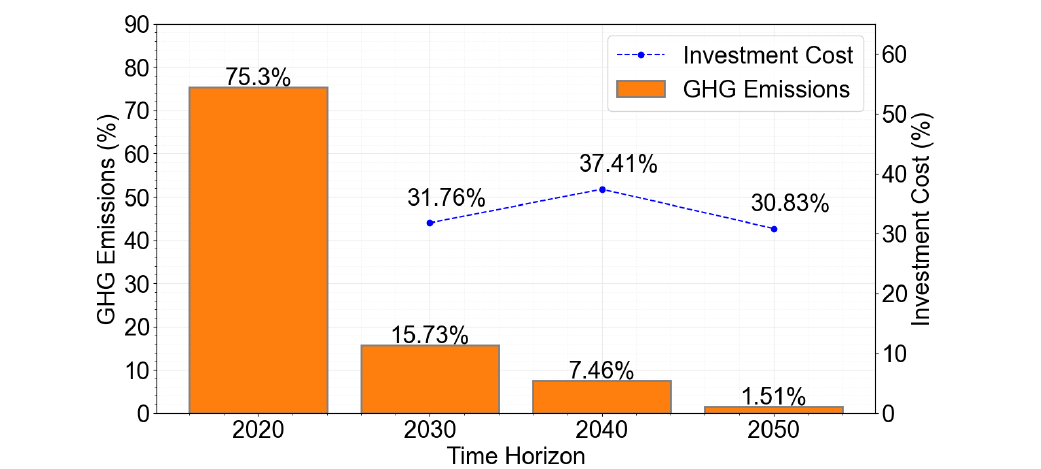
Figure 15. Alternative 4—Comparison between emissions and the investment cost for the Service